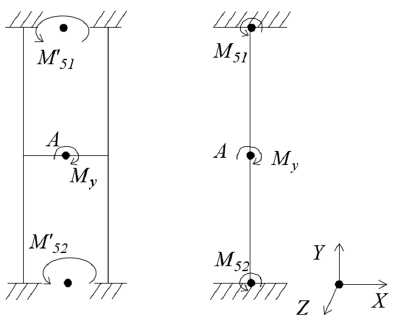
Figure 7. Mechanical models of floating beam and H-beam under M y .